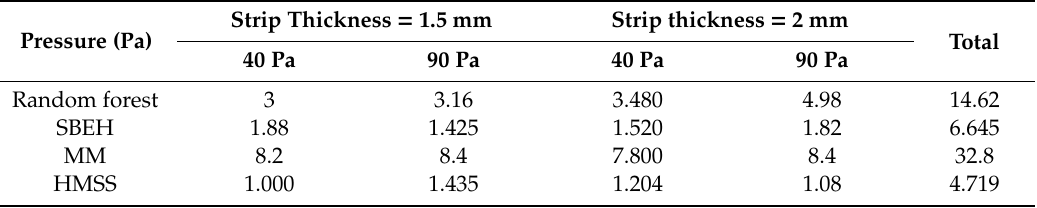
Table 3. Prediction results of the maximum and minimum height in the vibration state.